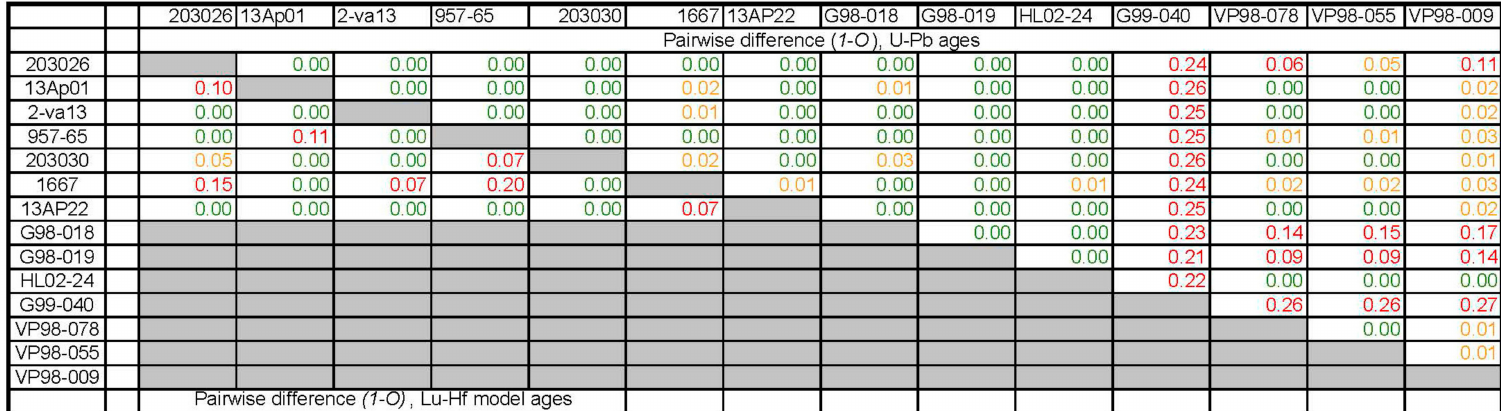
Figure 5. Degree of overlap between confidence intervals of cumulative distribution curves according to [31,32] for Lower Paleozoic rocks from Kara Terrane. Green shows full overlap, yellow shows less than 5% di ff erence, and red shows more than 5% di ff